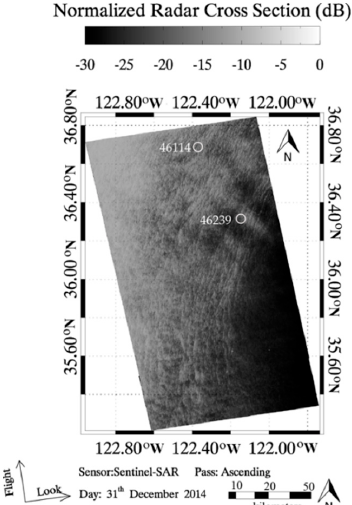
Figure 1. An example of collected C-band VV-polarization Sentinel SAR image taken at 02:06 UTC on 31 December 2014 in the Western U.S. coastal area. The observations from buoys were measured at 02:10 UTC.